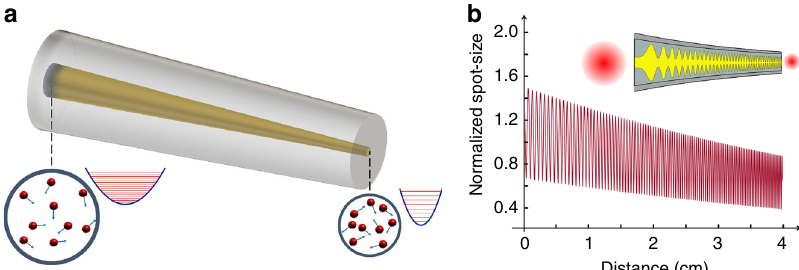
Fig. 1 Acceleration of intermodal collisions in a tapered multimode fi ber. a Schematic of a core-decreasing parabolic multimode fi ber. As the fi ber core is reduced in size, the spacing between the propagation eigenvalues increases, leading to an acceleration in intermodal collisions and energy exchange. b Evolution of the spot-size as a function of the propagation distance in a 4-cm tapered fi ber when its core decreases from 40 to 10 µ m. In this example, the input spot-size was chosen to be 1.5 times larger than that of the fundamental mode. As shown in b , the oscillations in the optical beam